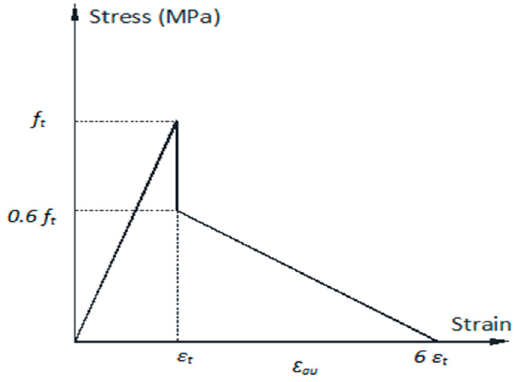
Figure 7. Stress–strain curves for epoxy adhesive.